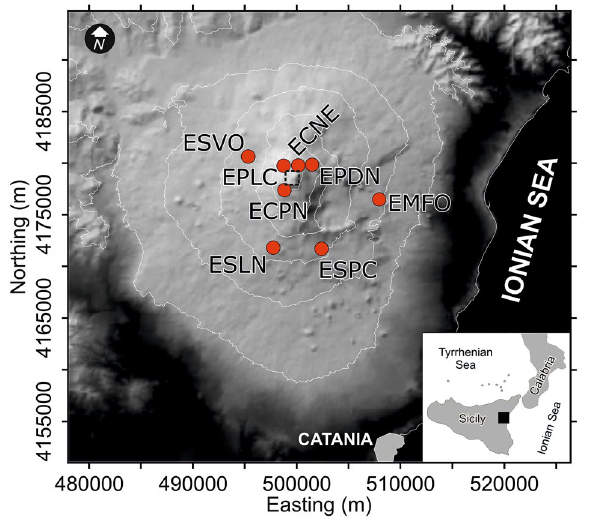
Figure 1. Digital elevation model (DEM) of Etna from TINITALY/01 by Tarquini et al. 26 . The DEM is referenced in the UTM WGS 84 zone 32 projection system, and is published with a CC BY 4.0 license (https:// doi. org/ 10. 13127/ TINIT ALY/1.0; last access 14 September 2022). Red circles mark the location of the permanent seismic stations we used in this study. The dashed square marks the area of Etna’s summit craters.